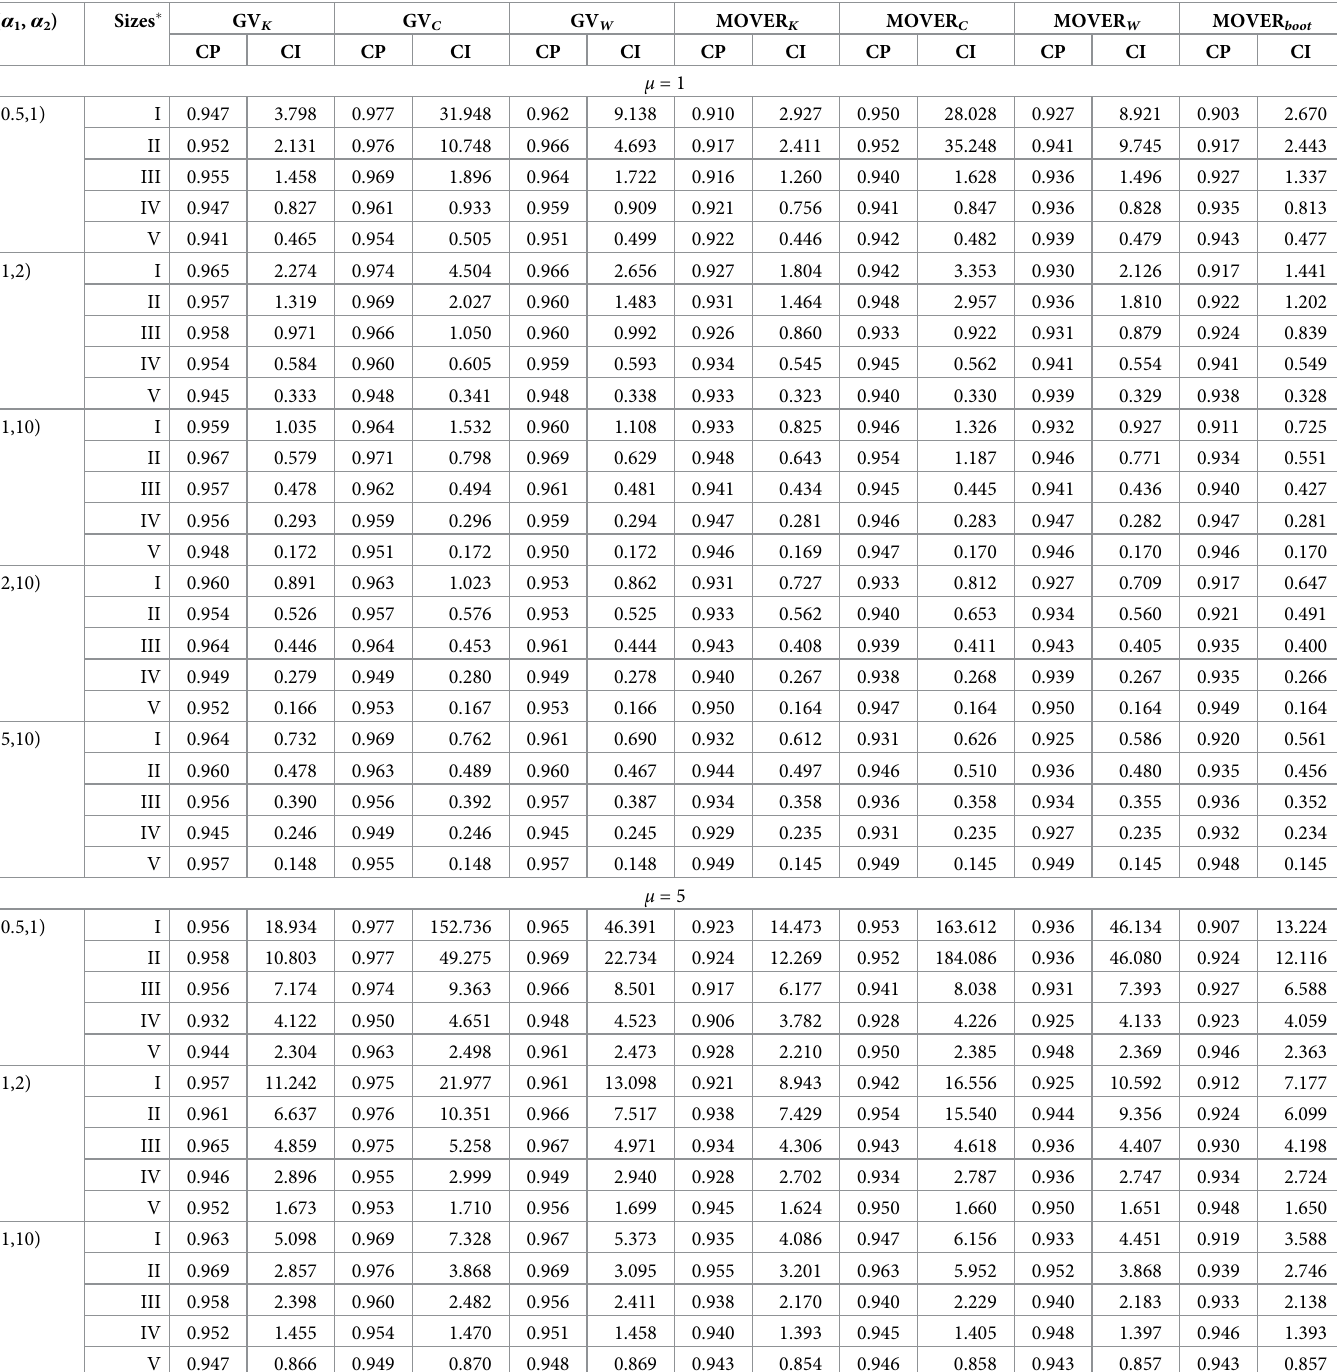
Table 1. Coverage probabilities (CP) and length of confidence interval (CI) of proposed 95% confidence intervals for the common gamma mean (2000 simulations) with two independent samples ( K =